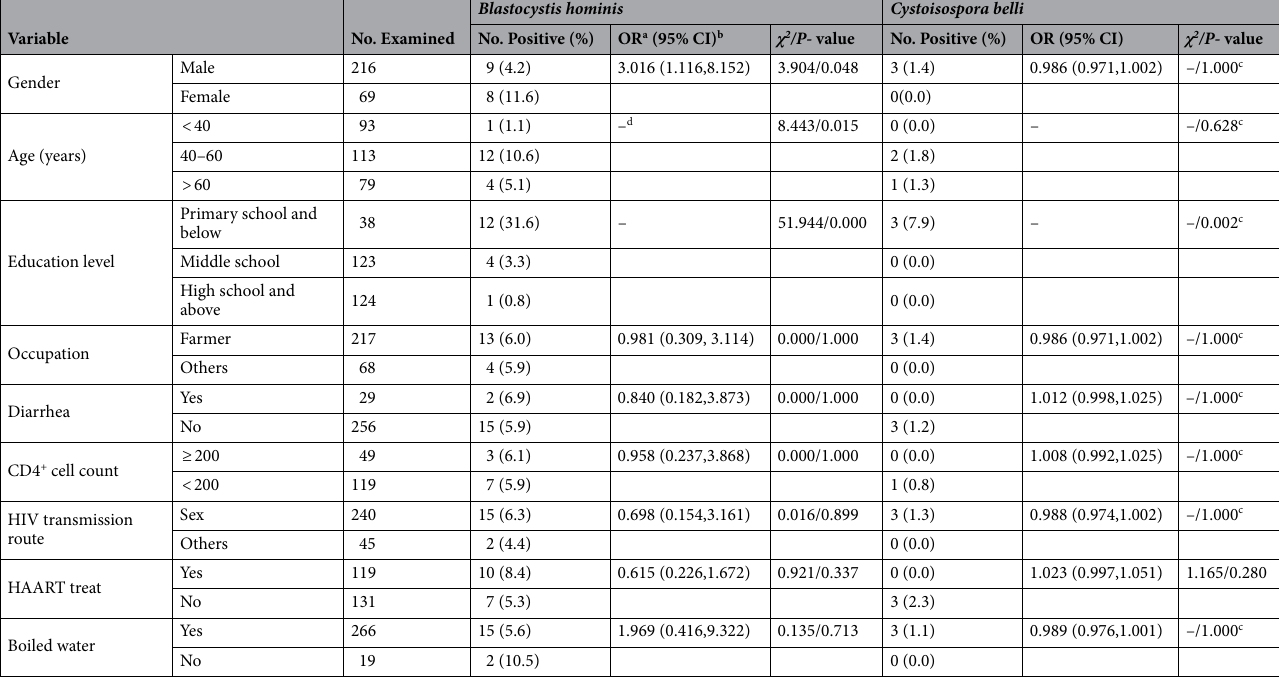
Table 1. Basic information on participants and assessment of risk factors for B. hominis and C. belli. a OR Odds ratio. b CI Confidence interval. c Fisher’s exact test. d The “–” symbol indicates the data was not be